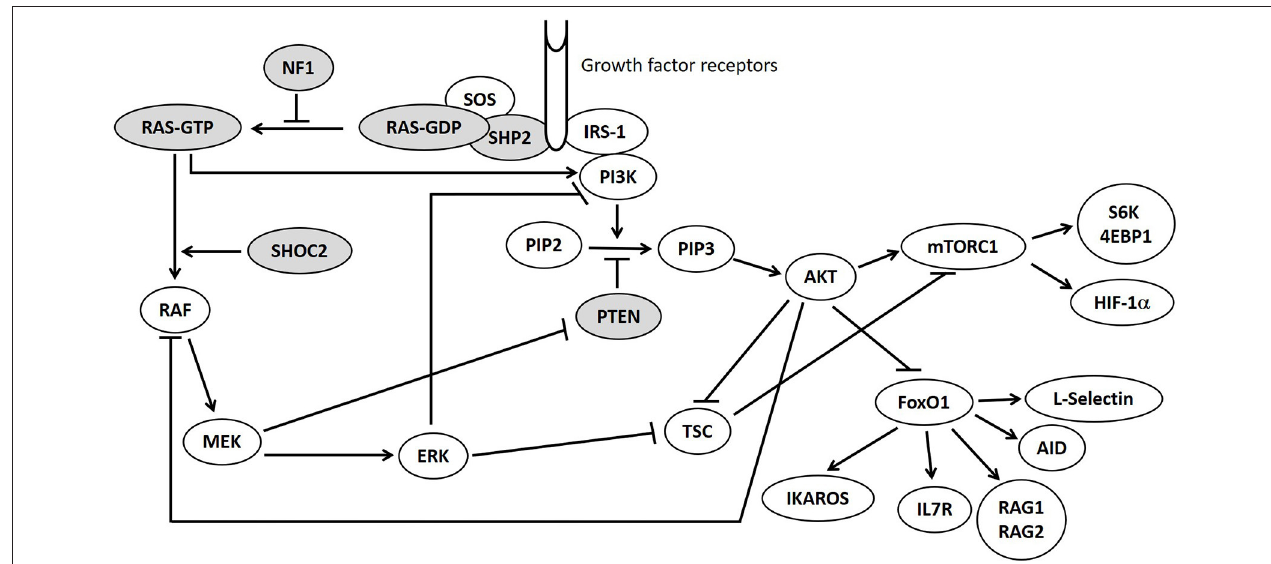
FIGURE 1 | RAS/MAPK and PI3K-AKT-mTOR pathways. Mutations in genes displayed in gray circles are responsible for Neurofibromatosis type 1 (NF1), Bannayan-Riley-Ruvalcaba syndrome (PTEN) and Noonan syndrome (PTPN11, KRAS, SHOC2) in our